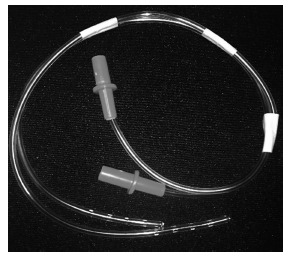
Innovative crafted capnography/oxygenation catheter